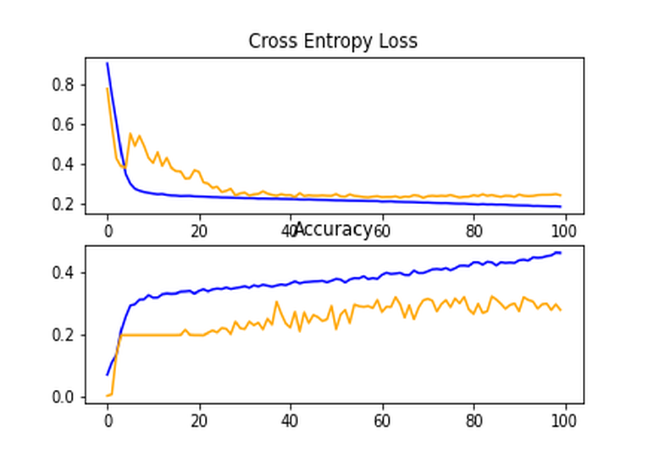
Fig. 7. To All the Boys I’ve Loved Before (2018) Output: Comedy, Drama, Romance Ground Truth: Comedy, Drama,